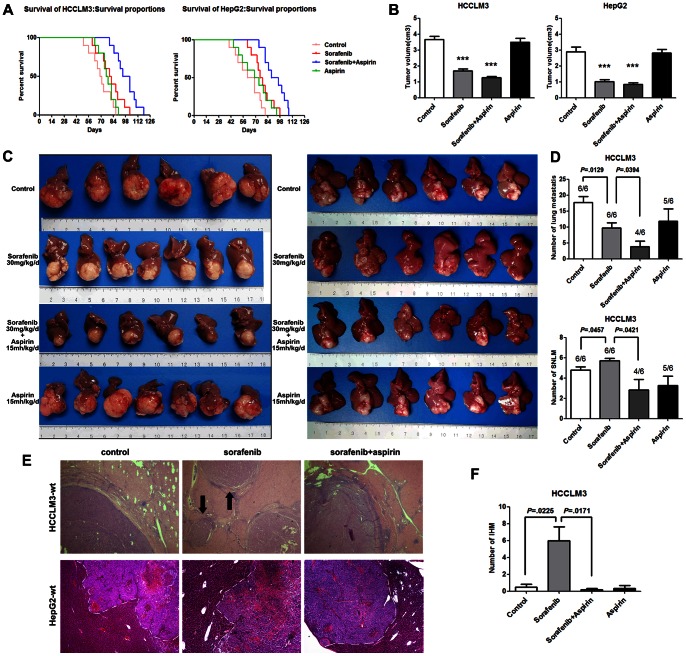
Aspirin suppressed the pro-invasion and pro-metastasis effects of sorafenib in orthotopic HCC models.(A) Median survival was improved by sorafenib treatment with or without aspirin in orthotopic HCCLM3 and HepG2 models. Moreover, sorafenib combined with aspirin significantly prolonged median survival compared to sorafenib alone (98.5±3.85 days vs 81.0±4.31 days in the HCCLM3-wt model, P = 0.0076; 92.3±3.82 days vs 77.7±3.54 days in the HepG2-wt model, P = 0.0122). (B) In the HCCLM3-wt model (left panel), tumor size was 1.70±0.12 cm3 in the sorafenib group (P<0.001), 1.27±0.08 cm3 in the group treated with both sorafenib and aspirin (P<0.001), and 3.68±0.18 cm3 in the control group. In the HepG2-wt model (right panel), tumors were smaller in the sorafenib group (1.02±0.11 cm3, P<0.001), and the group treated with combined sorafenib and aspirin (0.84±0.11 cm3, P<0.001), compared with controls (2.90±0.29 cm3). (C) In the HCCLM3-wt model (left panel), the sorafenib group had more intrahepatic metastases (IHM), although tumor size was smaller, and the group treated with combined sorafenib and aspirin had significantly fewer IHM. The HepG2-wt model (right panel), was characterized by invasive growth, and sorafenib did not further increase its invasiveness and metastasis. However, tumor margins became clearer in the group treated with combined sorafenib and aspirin. (D) In the HCCLM3-wt model, there were obviously fewer lung metastases in the sorafenib group (9.67±1.71) compared to the control group (17.67±1.94, P = 0.0129) The incidence of lung metastasis (6/6) was not decreased in the sorafenib group. However, the standardized number of lung metastases (SNLM) was greater in the sorafenib group (5.72±0.24) than in the control group (4.77±0.33, P = 0.0457). In the group treated with combined aspirin and sorafenib, the incidence of lung metastasis (4/6) and SNLM were distinctly decreased compared with the group treated with sorafenib alone (2.84±1.04 vs 5.72±0.24, P = 0.0421). (E) Hematoxylin-eosin staining confirmed that sorafenib induced more IHM in the HCCLM3-wt model, and aspirin was able to reverse the adverse effect. In addition, aspirin was able to effect a clearer margin in the HepG2-wt model. (F) Comparison of IHM in the HCCLM3-wt model. The number of IHM was greater in the sorafenib group compared to the control group (6.00±1.65 vs 0.50±0.34, P = 0.0225) and lower in the sorafenib and aspirin combined therapy group compared to the sorafenib group (0.17±0.17 vs 6.00±1.65, P = 0.0171).